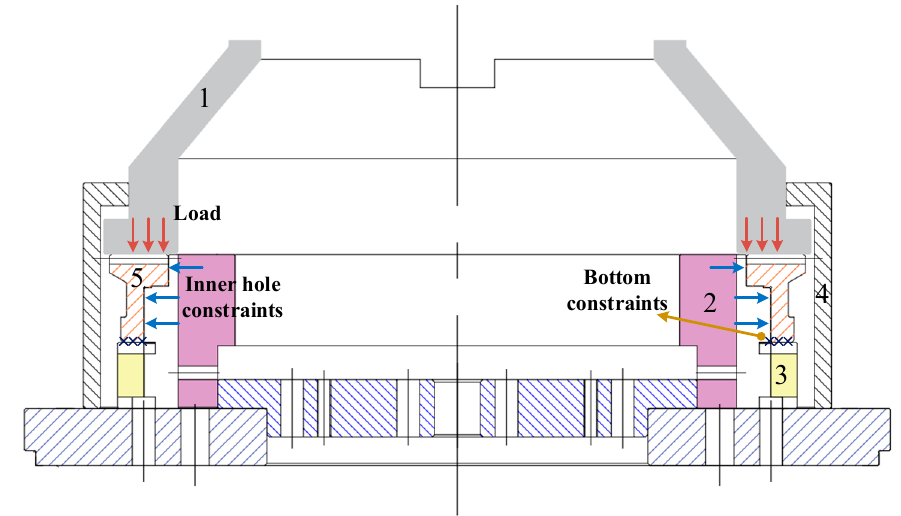
Figure 17. Assembly of the face gear quenching press: 1. upper die assembly; 2. inner hole support ring; 3. lower die assembly; 4. oil sealing ring; 5. The face gear.